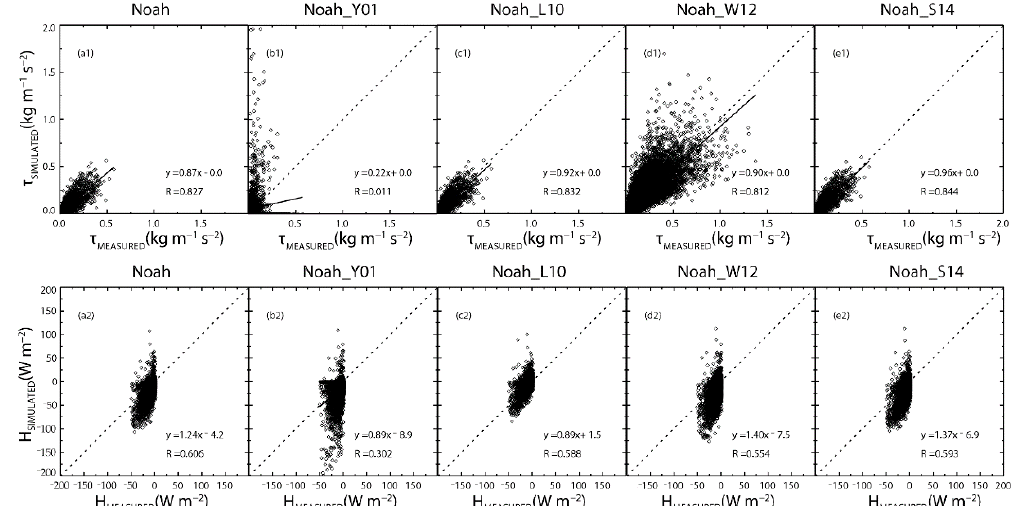
Figure 5. Comparison of simulated momentum and sensible heat fluxes with observed values under the stable condition. The marker ( a – e ) represent scheme of Noah, Noah_Y01, Noah_L10, Noah_W12, and Noah_S14, respectively. The 1 and 2 represent momentum and sensible heat fluxes. For example, a1 means the simulated momentum with the scheme of Noah.